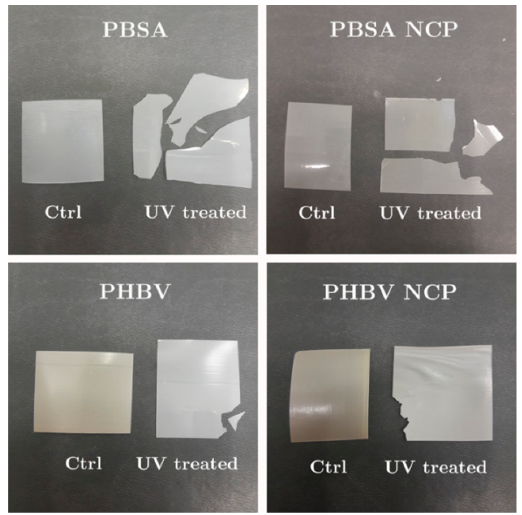
Figure 1. Pictures of the materials before and after accelerated aging.